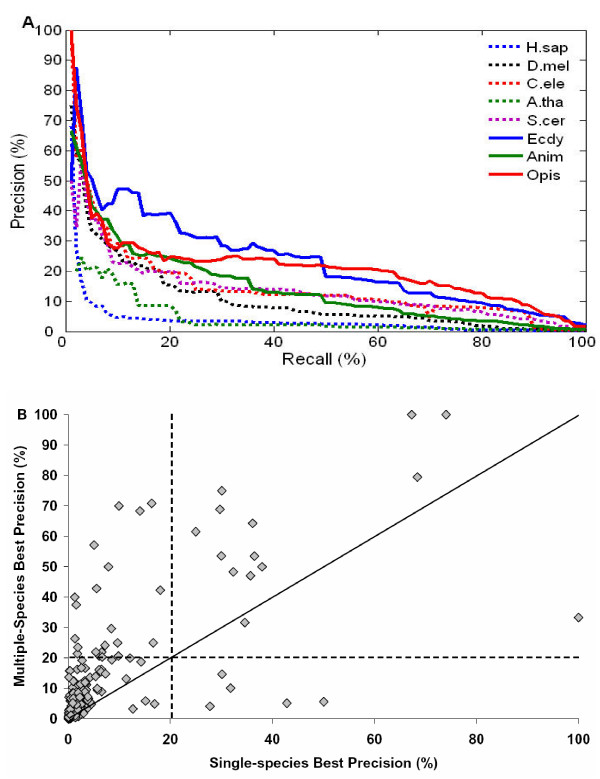
Accuracy of single- versus multiple-organism searches. A. Precision, averaged across all GenMAPP pathways, is plotted against different levels of recall. The results obtained for individual PMT nodes are shown as separate lines with single-organism results shown as dashed lines and multiple-organism node results shown as solid lines. Average precisions for A. thaliana, H. pylori, Eukaryote, and Cellular nodes are not shown because each had fewer than 10 pathways with the minimum number of query genes. B. The highest precision level at 50% recall rate for all single-organism nodes versus multiple-organism nodes. Each dot corresponds to the precision obtained by the search-engine for a single pathway. Solid line indicates y = x, the line of equal performance; multiple-organism searches resulted in higher precision for pathways above the line and a lower precision for pathways below the line. Dashed lines indicate a high precision rate of 20%.